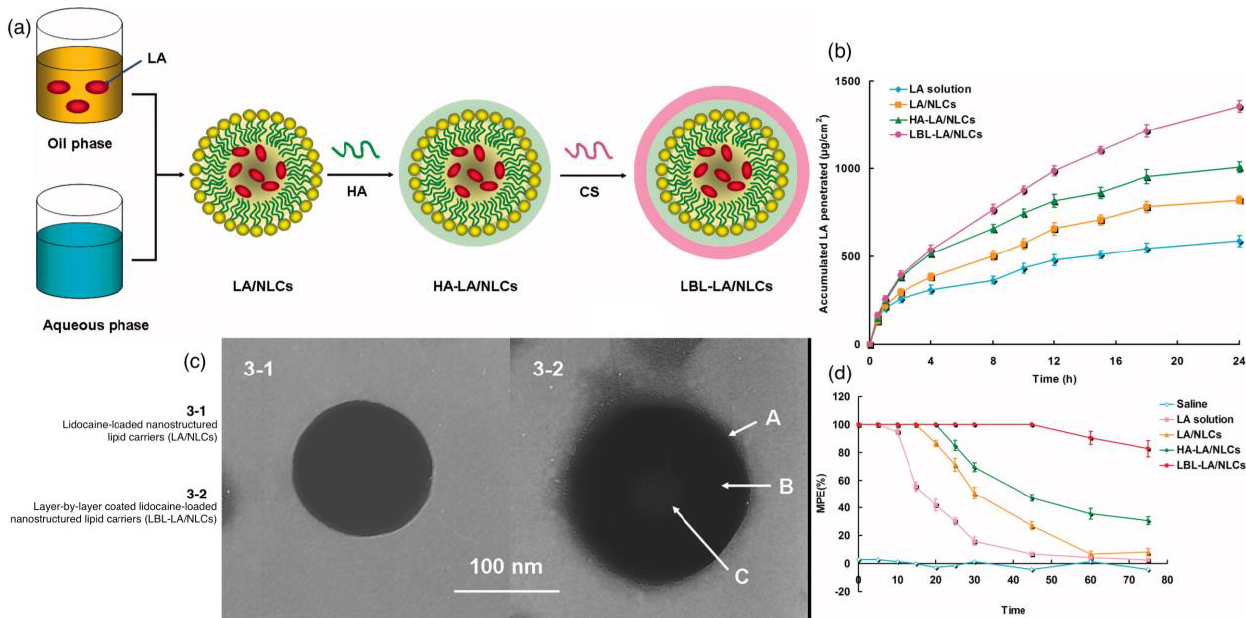
Figure 5. ( a ) Scheme of the fabrication of LBL-LA/NLCs. ( b ) In vitro permeation profiles of LA from different formulations. ( c ) TEM images of the structural morphology of the LBL-LA/NLCs and LA/NLCs. Image 3-2 shows different shades of gray that indicate the multiple layers of coating from C being the innermost and A being the outermost. ( d ) In vivo TFL test for the evaluation of the local anesthetic effects of LA-containing formulations. Adapted with permission from [89].